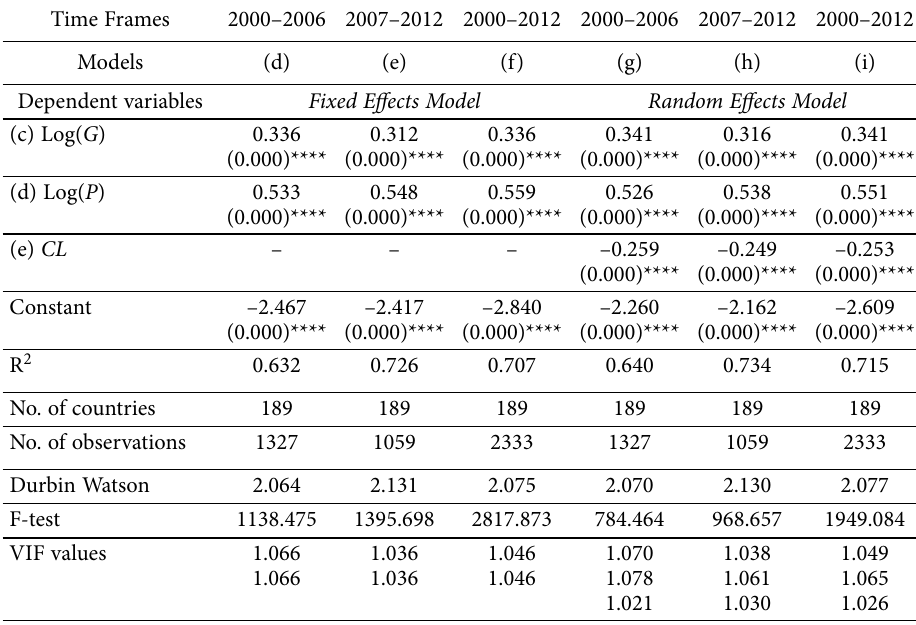
Table 2. Fixed and random effects